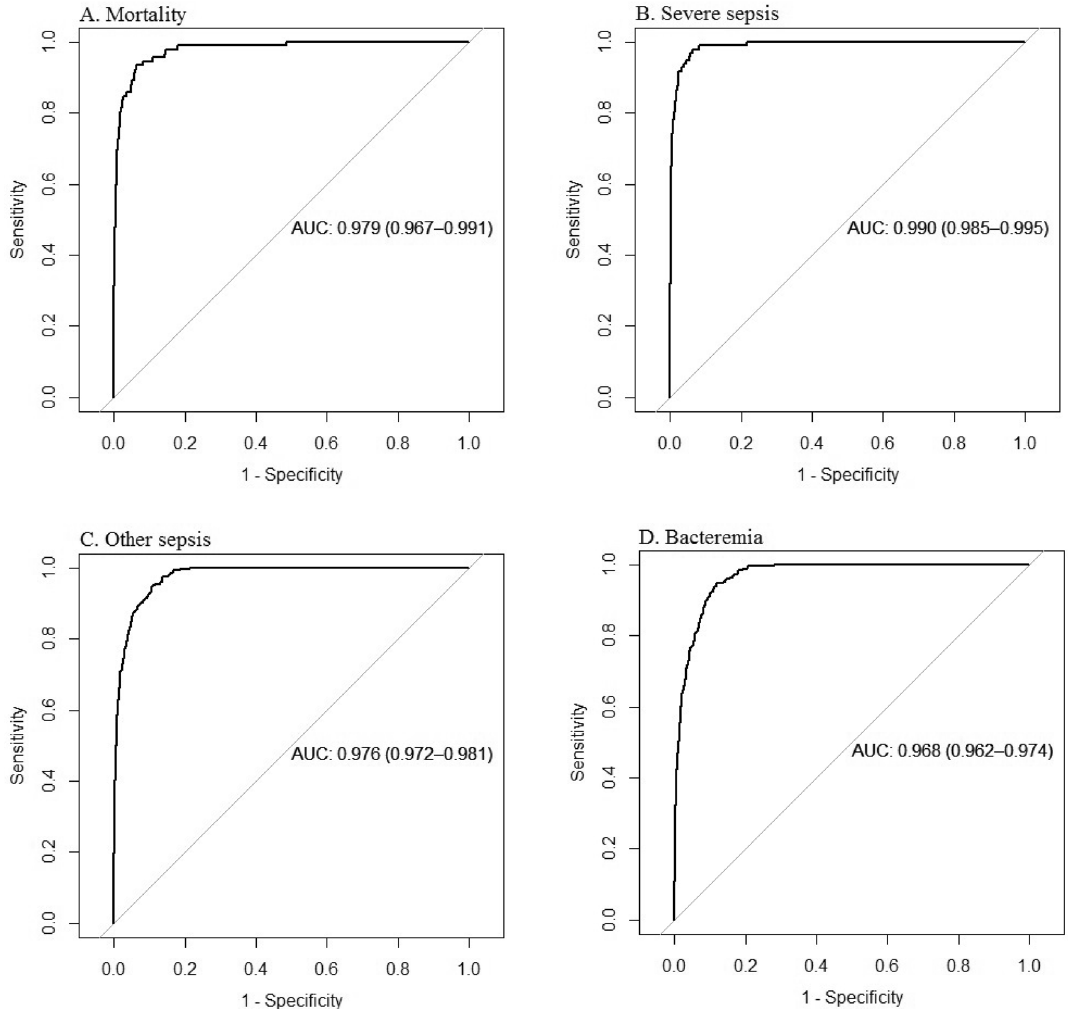
Figure 4. ( a ) One-versus-all areas under the receiver operator characteristic curves for mortality. ( b ) One- versus-all areas under the receiver operator characteristic curves for severe sepsis. ( c ) One-versus-all areas under the receiver operator characteristic curves for other/non-severe sepsis. ( d ) One-versus-all areas under the receiver operator characteristic curves for sepsis. Risk of severe sepsis is elevated in patients who had received carbapenem and other antibiotics during a previous hospitalization. This may indicate that there are lingering effects of past or recent bacterial infections treated with carbapenem that may elevate the risk of developing severe sepsis. This also suggests that certain patients are more susceptible to severe complications from infections. Identifying these high-risk patients in a timely manner can improve patient outcomes. The model performance estimates were relatively good given the class imbalance (patients with sepsis com- pared to those without). But the relatively high number of false positives required to capture a true positive (as captured by the number needed to evaluate) would likely run the risk of alert fatigue for severe sepsis if the posi- tive predictive values are not properly communicated to providers. However, further analyses of the false-positive predictions in the individual strata revealed that these groups of patients had high morbidity even without the diagnosis of severe sepsis. These false-positive patients included those requiring hospitalization and admission to the intensive care unit (ICU). In other words, even the model’s false positives for severe sepsis are of clinical utility to providers in the ED in predicting the risk of other decompensation events. This raises the question of whether the subject of deterioration is possibly more important to clinicians than just identification of sepsis or severe sepsis since screening and identification of criticality, of any kind, could be helpful to stimulate early and more general interventions. We believe that specific identification of sepsis and severe sepsis can prompt specific goal-directed interventions such as improved door to antibiotic times and early fluid resuscitation both of which are believed to be clinically important. Further, alerts generated on individual disease screening could be more useful than general alerts of criticality when it comes to achieving provider compliance with order sets. This study had several limitations. Sepsis was identified using diagnosis codes and the corresponding model was created using a single center dataset. Additional studies based on the use of a larger multicenter dataset